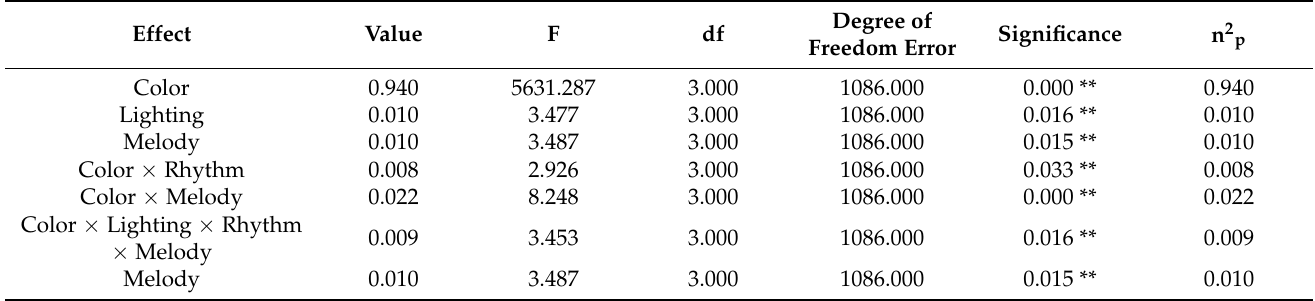
Table 5. MANOVA results of subjective cognition in deceleration scenario.